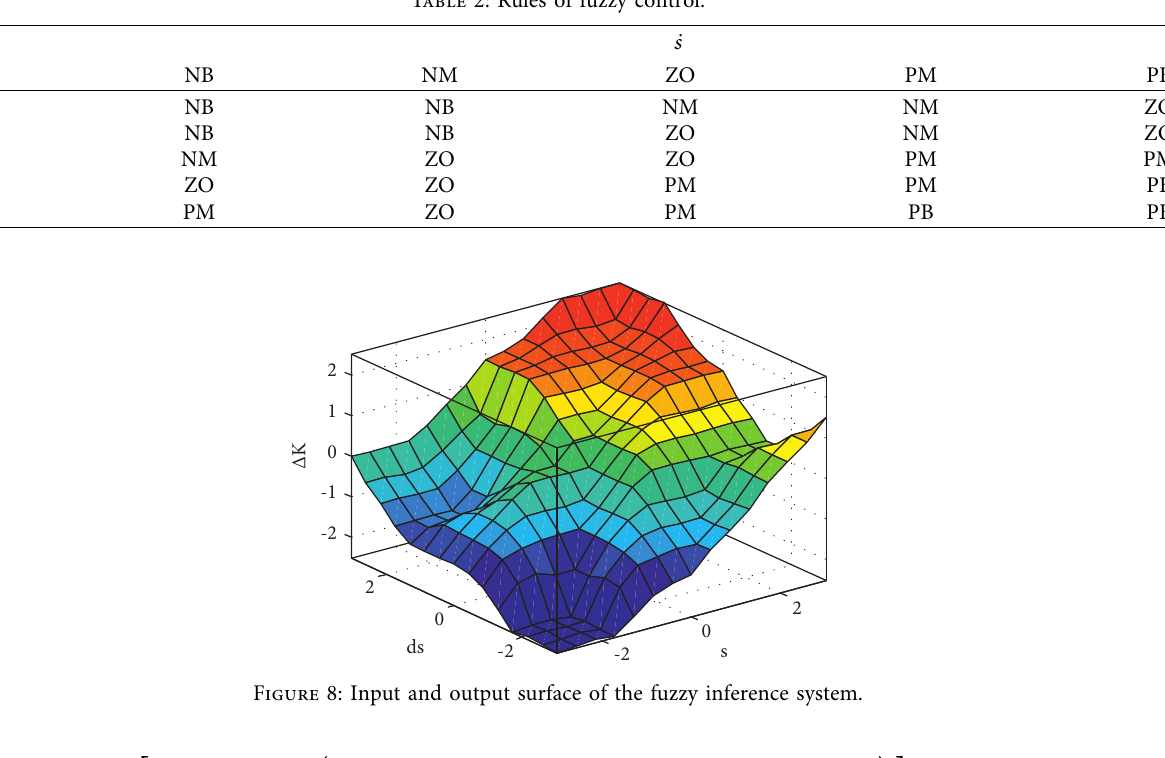
Figure 7: The structure block diagram of fuzzy sliding mode control for EMLHAS. Table 2: Rules of fuzzy control.